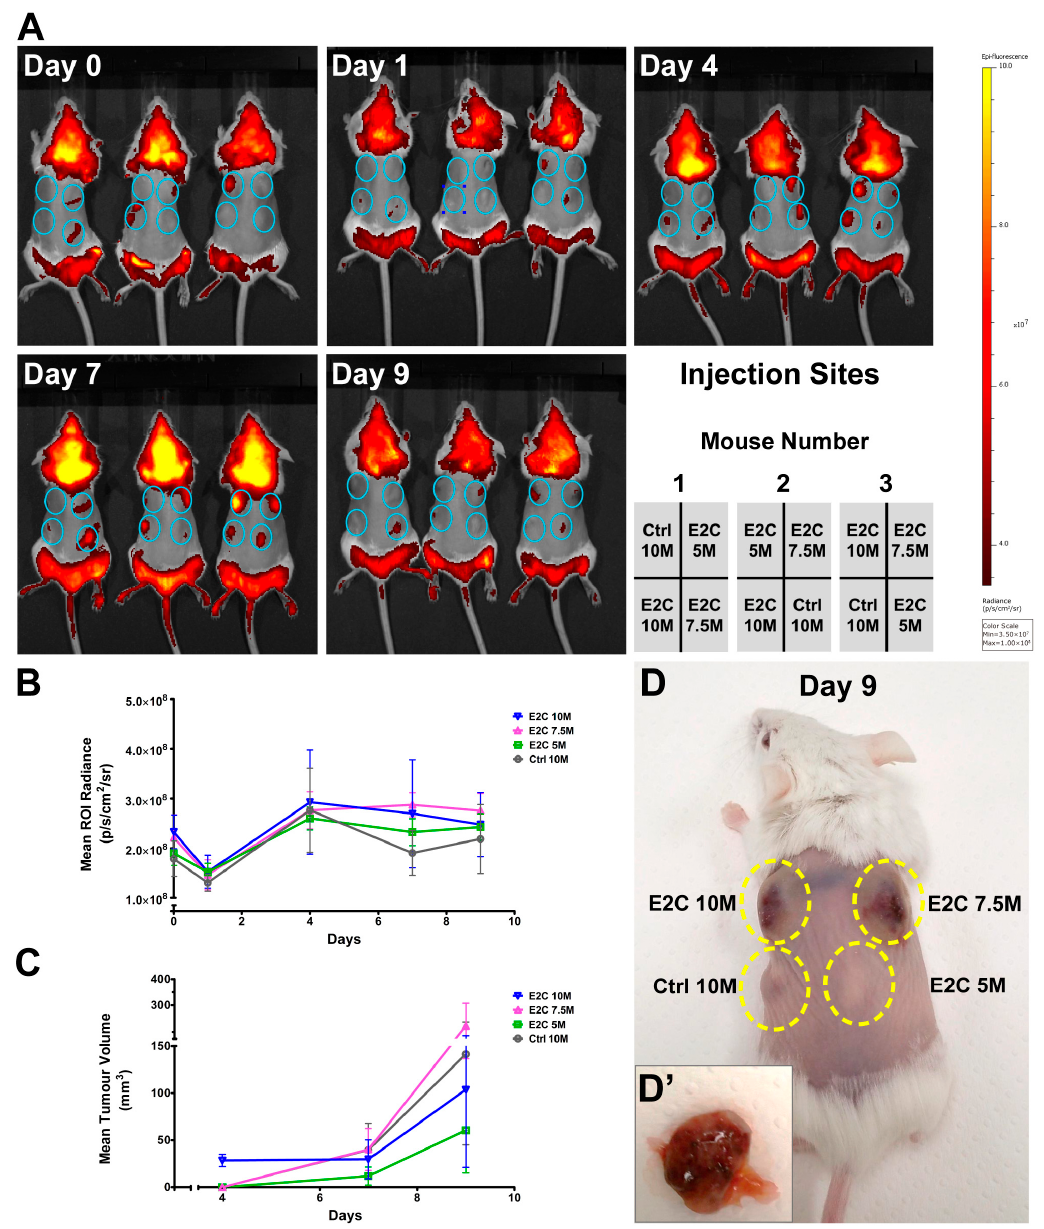
Figure 5. ( A ) IVIS images in vivo at days 0, 1, 4, 7 and 9 post injection of E2C + cells into the dorsal flanks of severe combined immunodeficient (SCID) mice. The emission filter of 605–660 nm wavelengths was applied to detect the fluorescent signal generated from Bra-GFP/Rosa26-E2C mESCs. The untransfected E14-Bra-GFP cells were used as negative controls. Blue circles show the injection sites of cells in the mice. Data are displayed in radiance units (p/s/cm 2 /sr); ( B ) Growth curves obtained based on the changes of mean region of interest (ROI) radiance post injection. ROI radiance was generated by IVIS software for the time points of day 0, 1, 4, 7 and 9; ( C ) Growth curves obtained based on the changes of tumour volume post injection. Tumour volume was calculated based on the manual measurements of tumours on day 4, 7 and 9; ( D ) Representative presence of tumours (dashed lines) from Bra-GFP/Rosa26-E2C mESCs in SCID mice (number 3) that formed from 5 × 10 6 , 7.5 × 10 6 and 10 × 10 6 injected cells on day 9 post injection. The untransfected E14-Bra-GFP cells were used as a negative control (10 × 10 6 cells); ( D ′ ) Dissected day-9 tumour that formed from 7.5 × 10 6 injected Bra-GFP/Rosa26-E2C mESCs showed high degree of vascularisation. M represents million (×10 6 ). Error bars represent ±SD ( B ) and ±SEM ( C ), respectively ( n = 3).